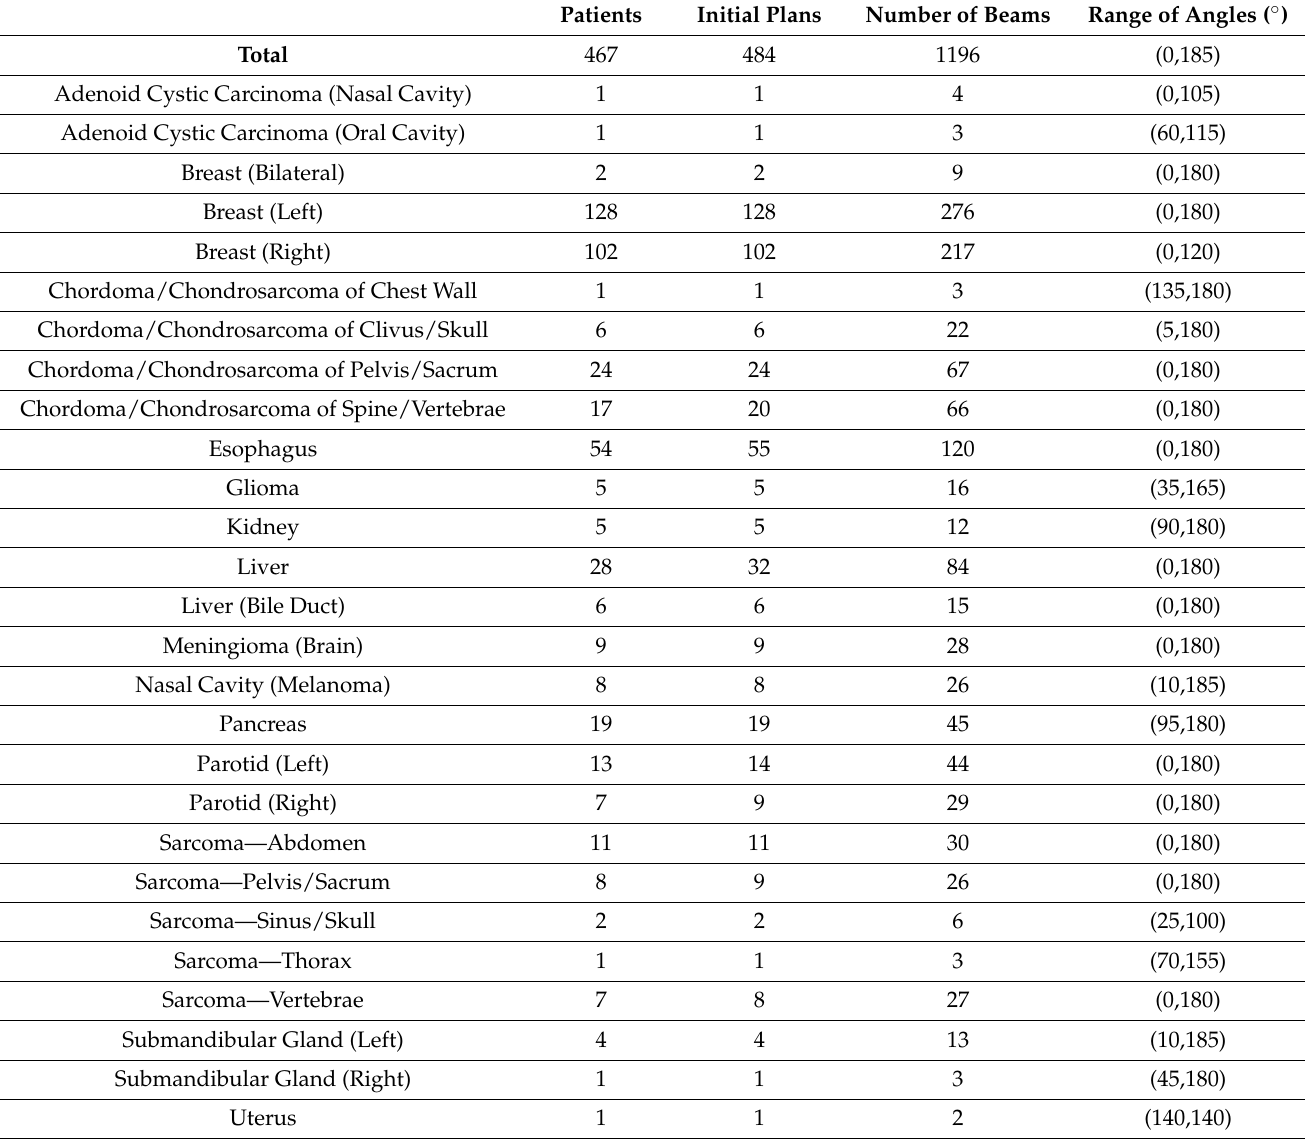
Table 1. Patients treated with proton therapy by treatment